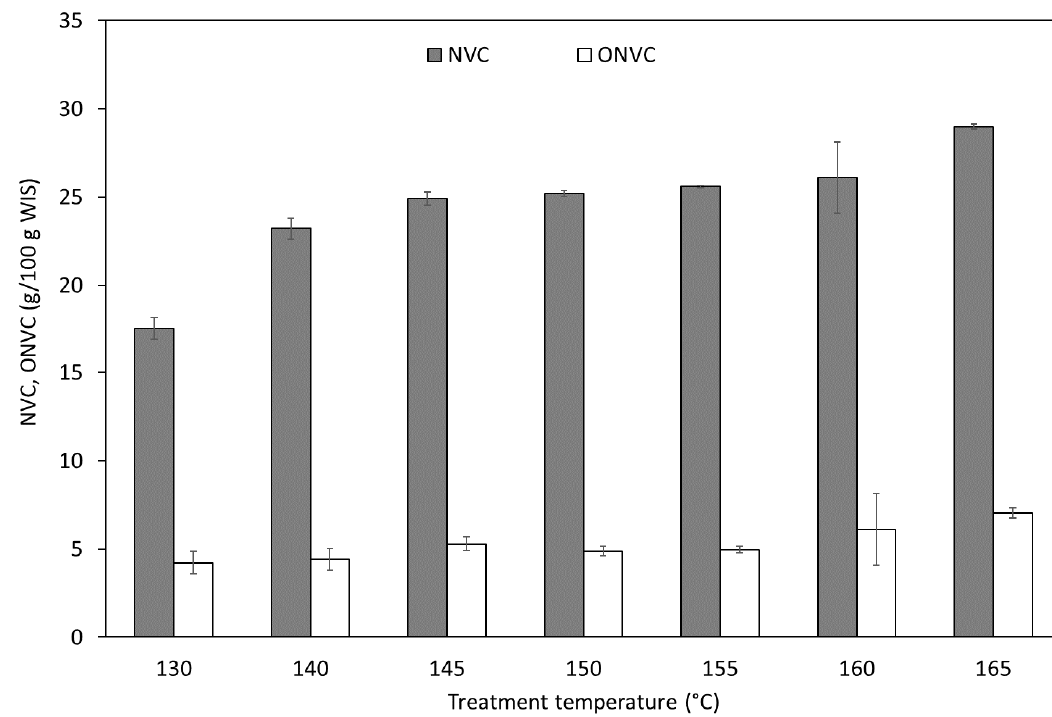
Figure 2. Temperature dependence of the concentration of NVCs and ONVCs in the reaction liquors. NVC, non-volatile compound; ONVC, other non-volatile compound or impurity.